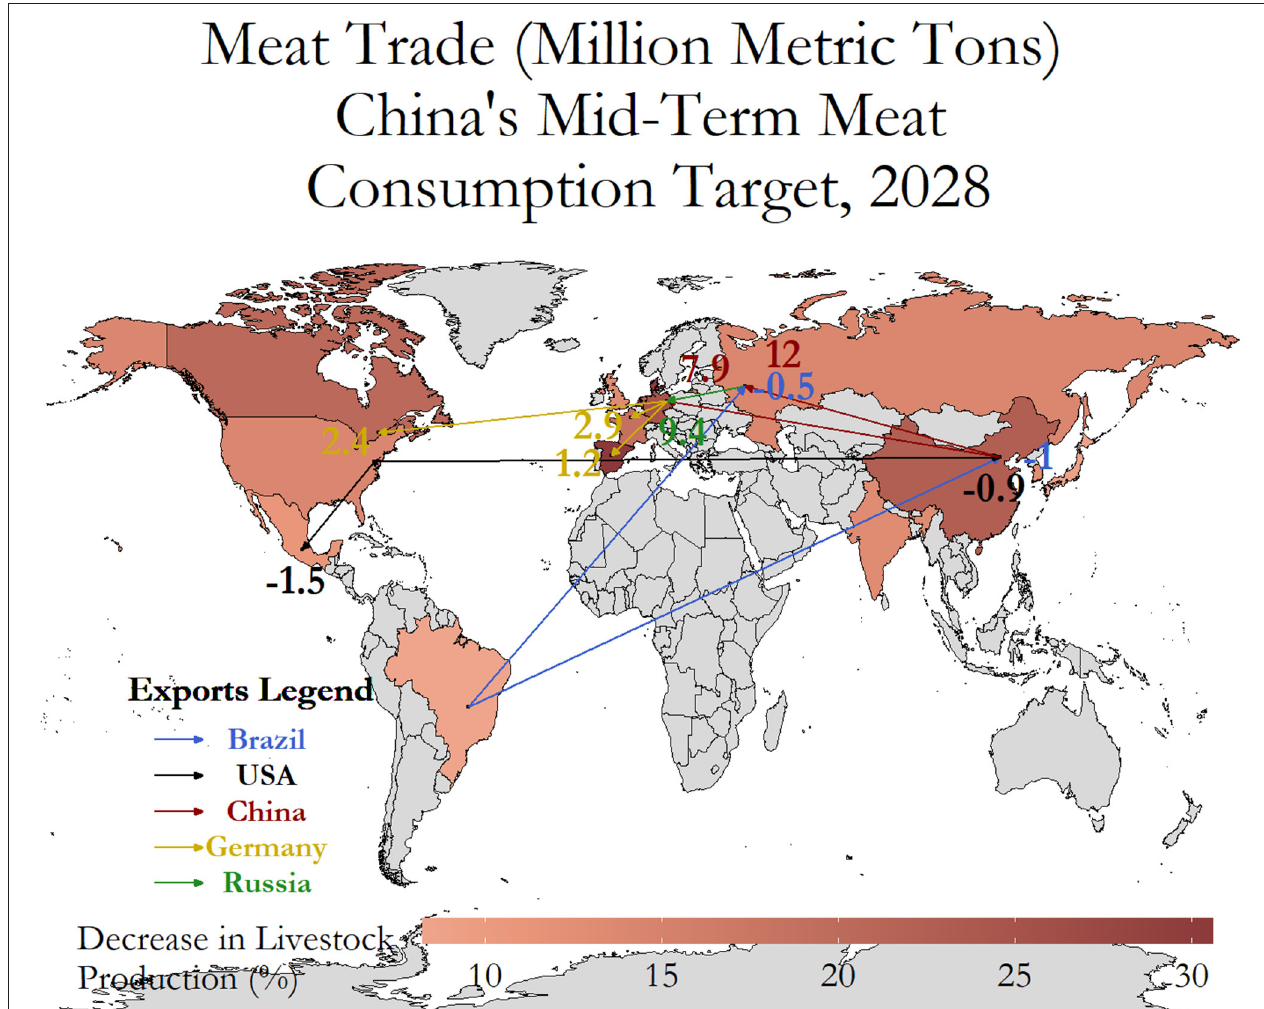
FIGURE 7 | Change in meat exports in million metric tons (MMT). Curtailment of China’s demand results in China having a surplus of low-cost meat that is sold in the global market. China becomes the leading exporter by increasing its exports to all countries via Germany and